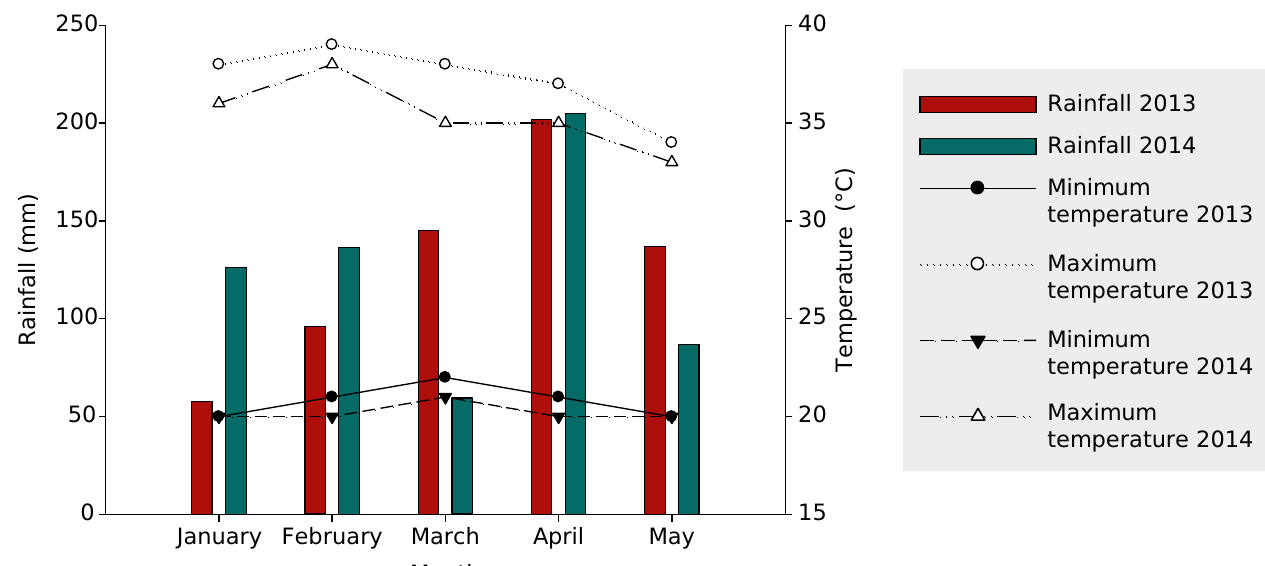
Figure 1. Rainfall and minimum and maximum air temperatures in each month of the rainy season in 2013 and 2014. Sobral, CE,